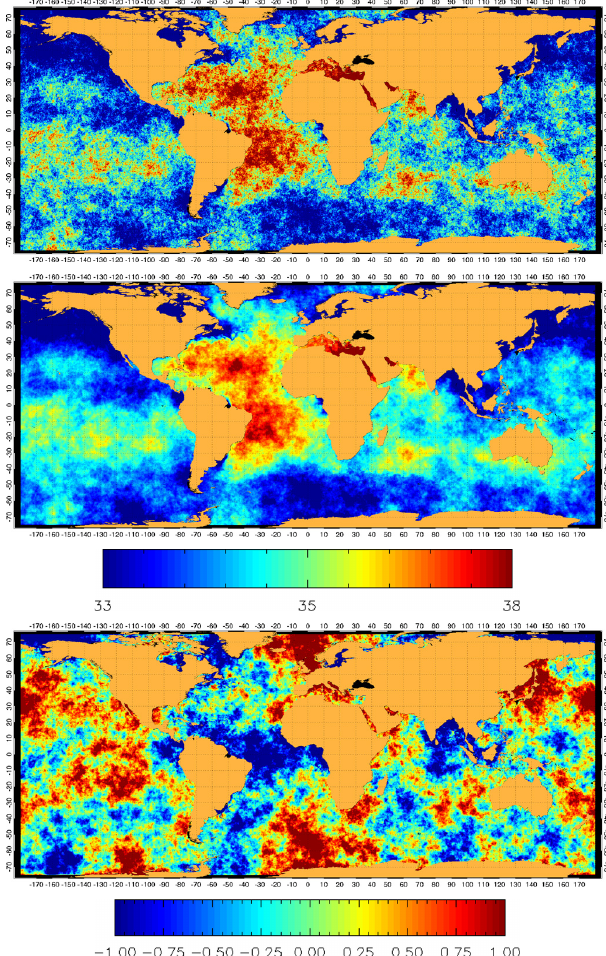
Fig. 11. Top: SSS after the introduction of strongly correlated noise with input noise of standard deviation σ i = 1psu. Middle: SSS map after filtering the map on top using the SST map as a template. Bot- tom: Differences between the original (no noise) SSS map and the fused SSS